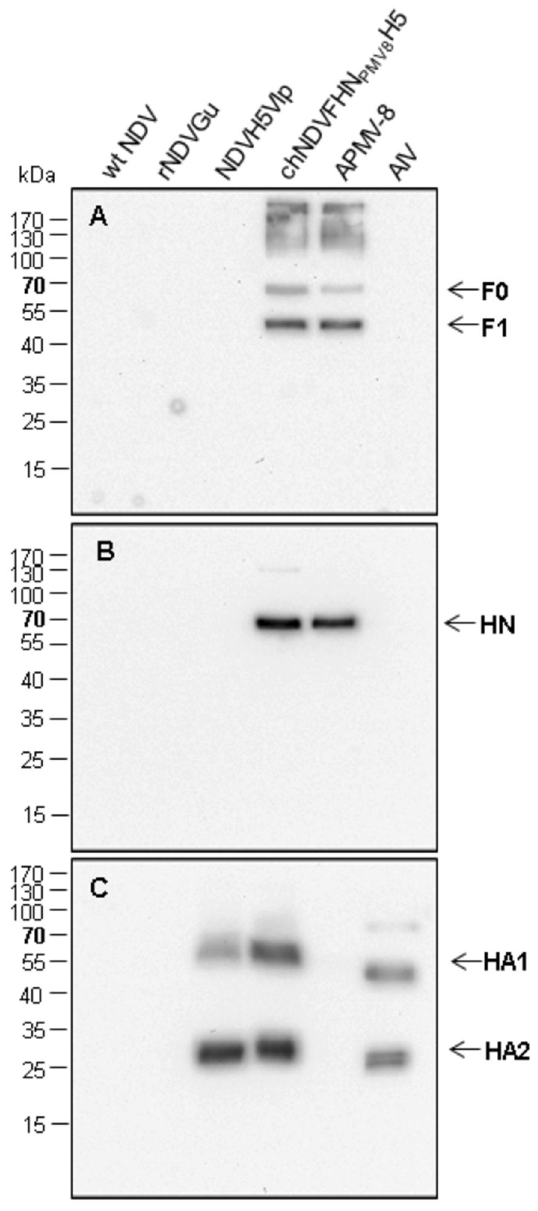
Figure 2. Protein expression and incorporation. After Western blotting of purified virion lysates, envelope proteins were visualized by immunostaining with rabbit-α-APMV-8 F (A), rabbit-α-APMV-8 HN (B) and rabbit-α-AIV H5 (C). After incubation with the respective primary antibody, binding of peroxidase-conjugated species-specific secondary antibody was detected by chemiluminescence substrate (Pierce). Identified proteins are indicated on the right, molecular weights of marker proteins (PAGE Ruler™ Prestained Protein ladder (Fermentas)) are indicated on the